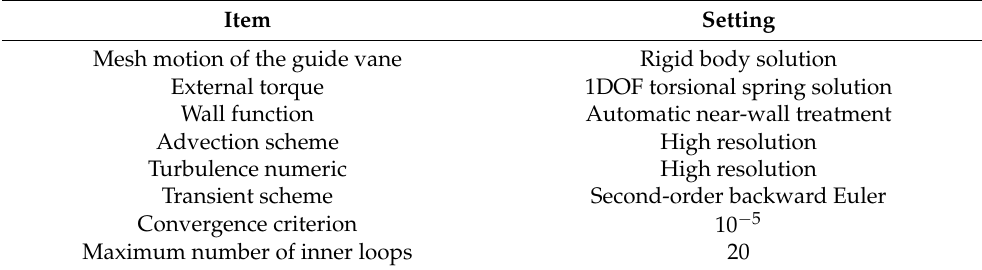
Table 1. The basic numerical settings for the URANS-1DOF coupling simulation. Item